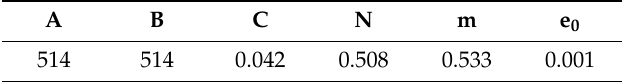
Table 6. AISI 316L material constants for J–C constitutive model